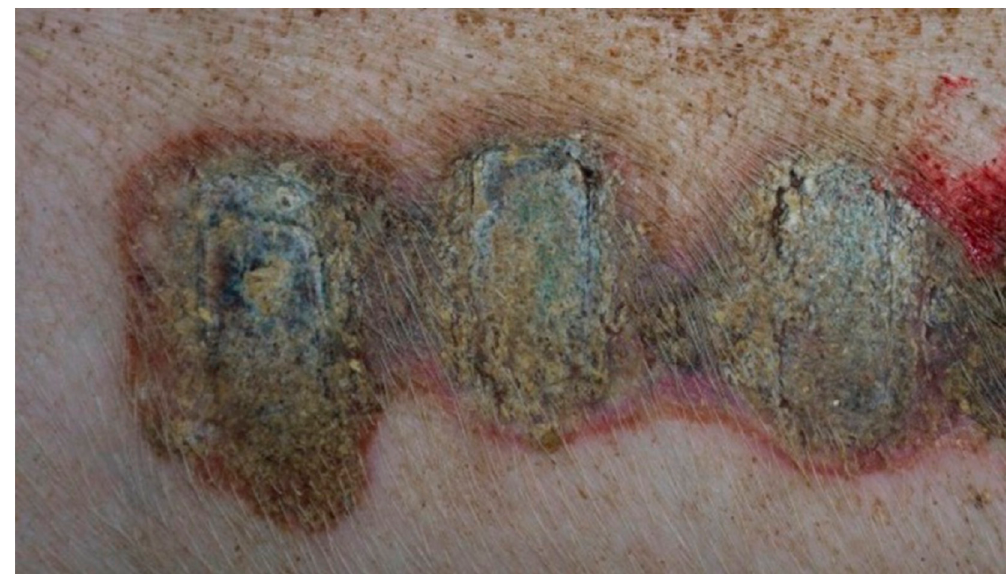
Figure 3. Group D3—burn wound treated with the ointment with 1% propolis and 1% nanosilver on day 5.